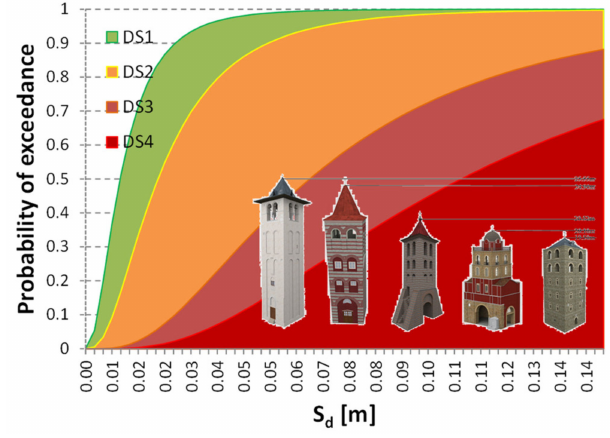
Figure 13. Vulnerability curves for the towers. Table 7. Mean ( m i ) and standard deviations β T , ds , i of damage state i